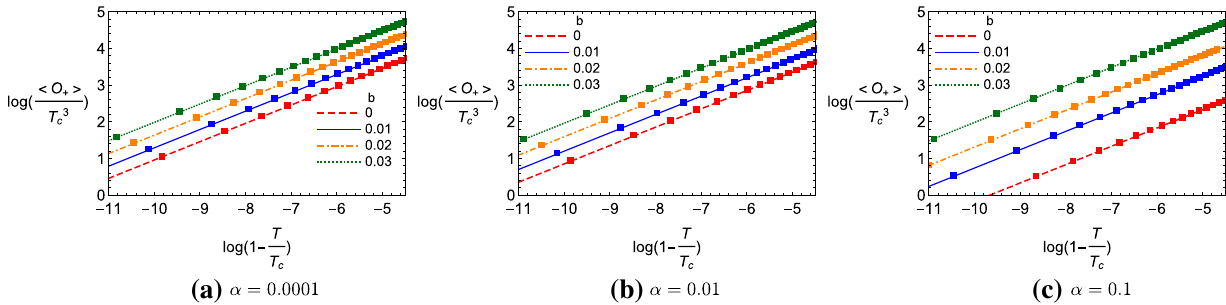
(cid:8) (cid:5) < O + > / T 3 versus log ( 1 − T / T c ) near the critical temperature T c for different values of b and c